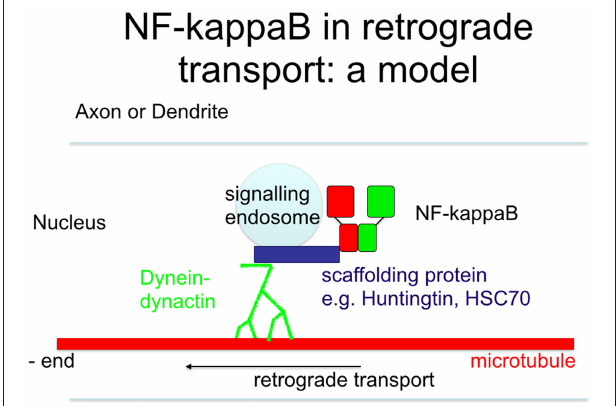
FIGURE 5 | Scheme of retrograde transport. Upon stimulation of neurons, the nuclear localization signal is unmasked, allowing its binding to scaffolding proteins outside of the signaling endosome. This complex is then transported retrogradely to the nucleus, where it finally activates NF- κ B target